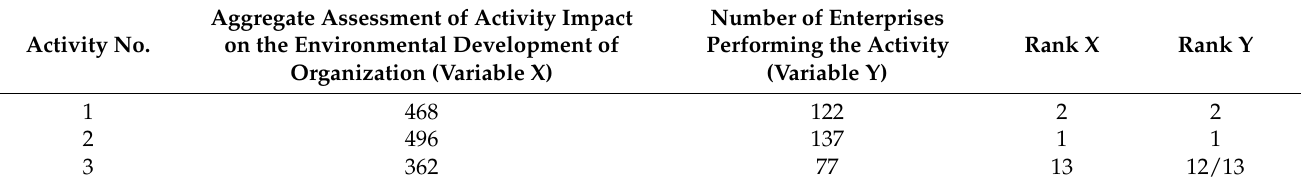
Table 4. The impact of activities fostering GIC on the environmental development of organizations and their implementation in Polish